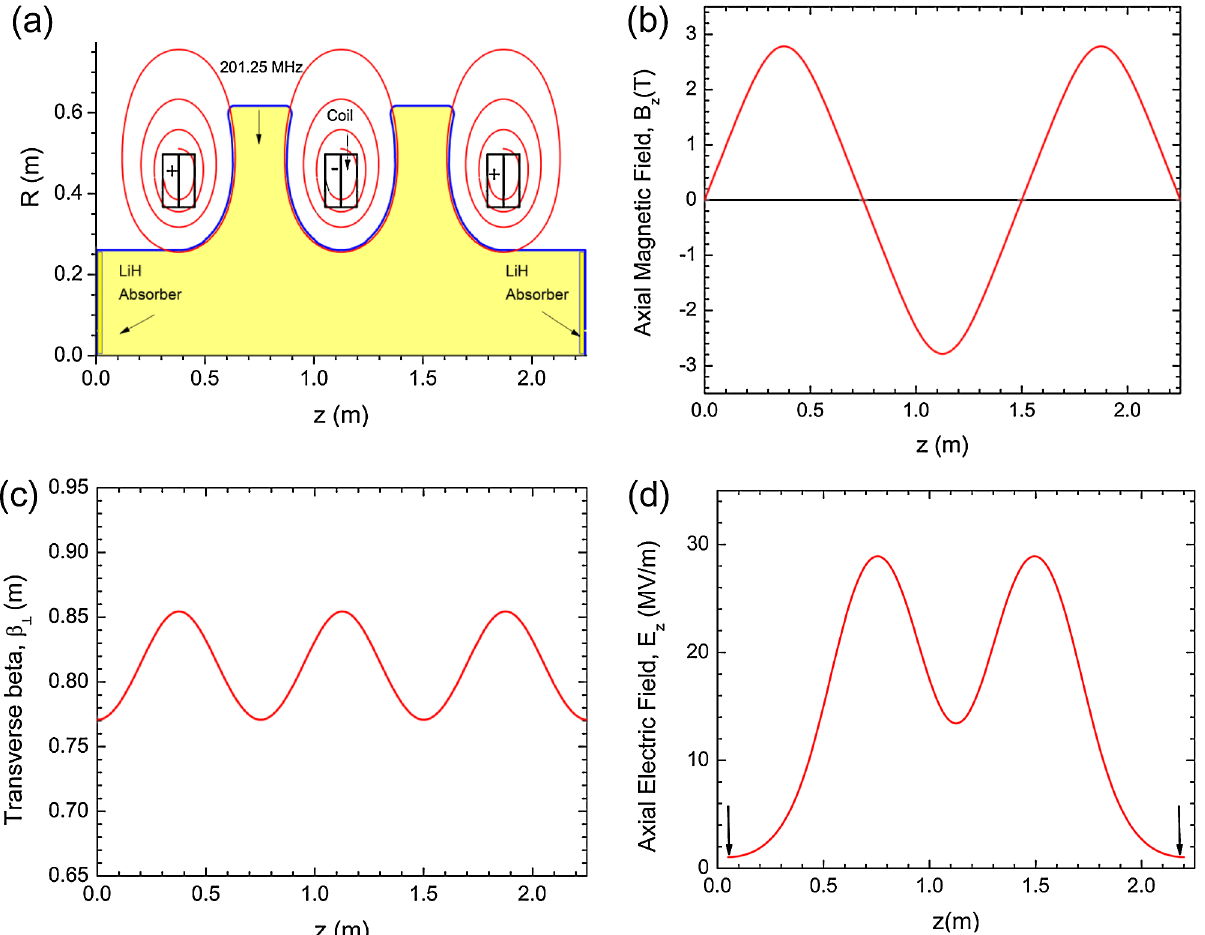
FIG. 5. (a) Three cells of our proposed cooling section with magnetically insulated cavities; (b) axial magnetic-field profile along the cells; (c) transverse beta function along the cells; and (d) on-axis longitudinal rf electric field at various positions along z , assuming that the average axial field of each cavity is 15 MV = m . The vertical arrows indicate the locations of the Be windows.